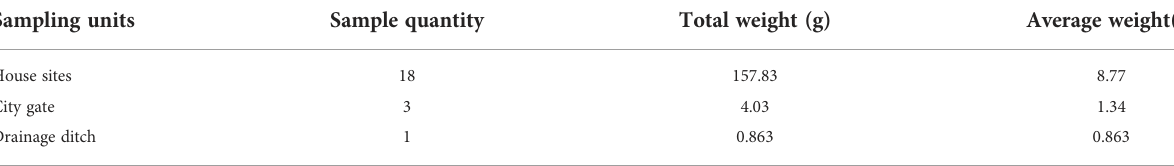
TABLE 1 Statistics of charred wood chips from fl otation samples in 2009 at the LMC site. Sampling